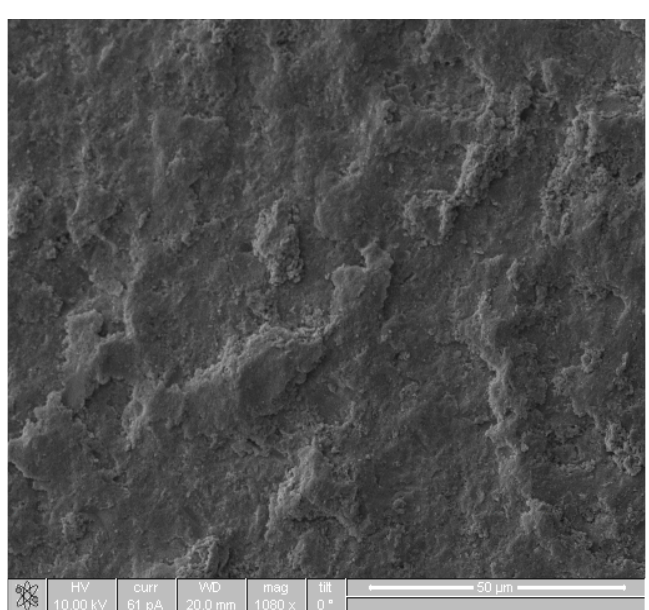
Figure 4. The arithmetical mean roughness tended to increase as the particle size of the between the surface treated and the untreated